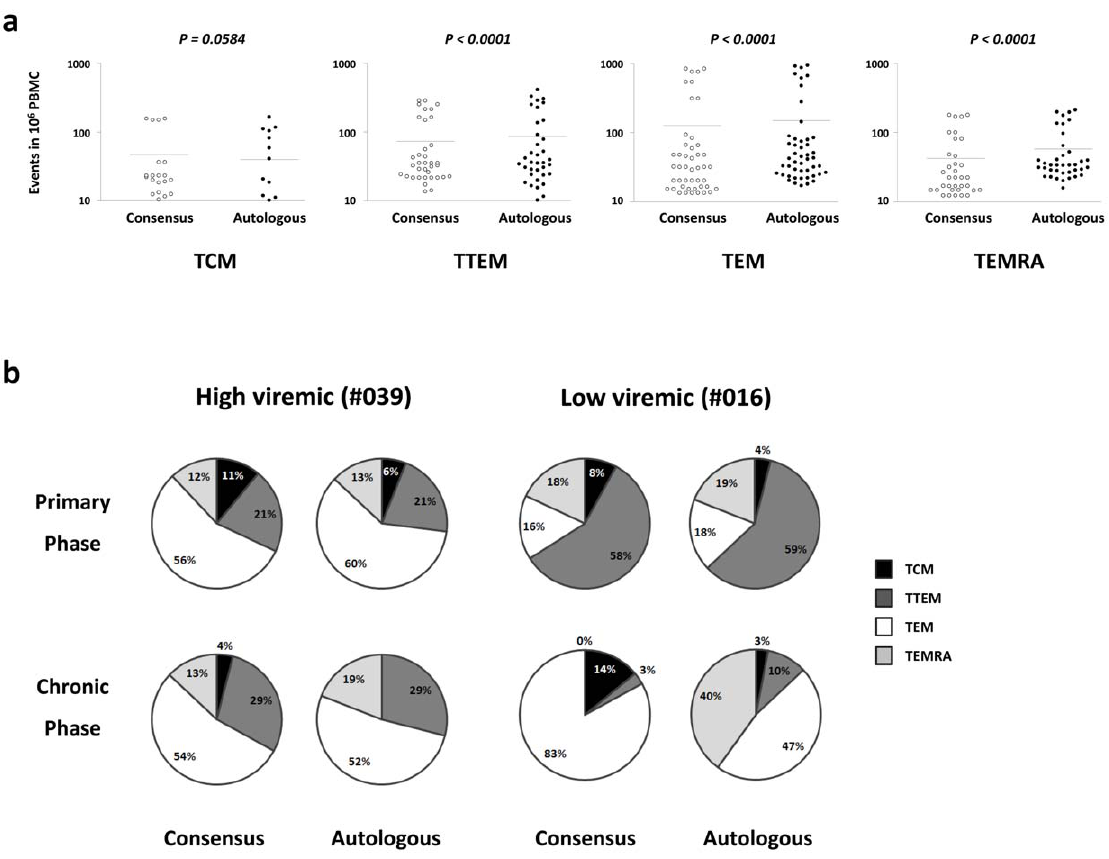
Figure 4. Greater frequency of terminally differentiated IFN- c producing CD8 + T-cells responding to autologous HIV-1 Nef peptides. (a) The frequency of terminally differentiated effector (CD8 + IFN- c + CD45RA + CCR7 2 CD27 2 ) and effector memory (CD8 + IFN- c + CD45RA 2 CCR7 2 CD27 2 ) T-cells targeting autologous HIV-1 Nef and clade-B consensus HIV-1 Nef peptides in both subjects. The phenotypes of IFN- c producing cells were detected by sequential gating of CD45RA, CCR7 and CD27 on CD3 + CD8 + IFN- c + T-cells. Each point in the graphs represents the response to one overlapping peptide. The responses of both subjects in both time points are represented in each graph. (b) The percentage of central memory (TCM), transitional memory (TTEM), effector memory (EM) and terminally differentiated effector (TEMRA) CD8 + T-cells targeting pairs of consensus and autologous HIV-Nef peptides in an ICS assay. The graph represents an example of the difference in the phenotype of stimulated CD8 + T-cells between the two subjects.